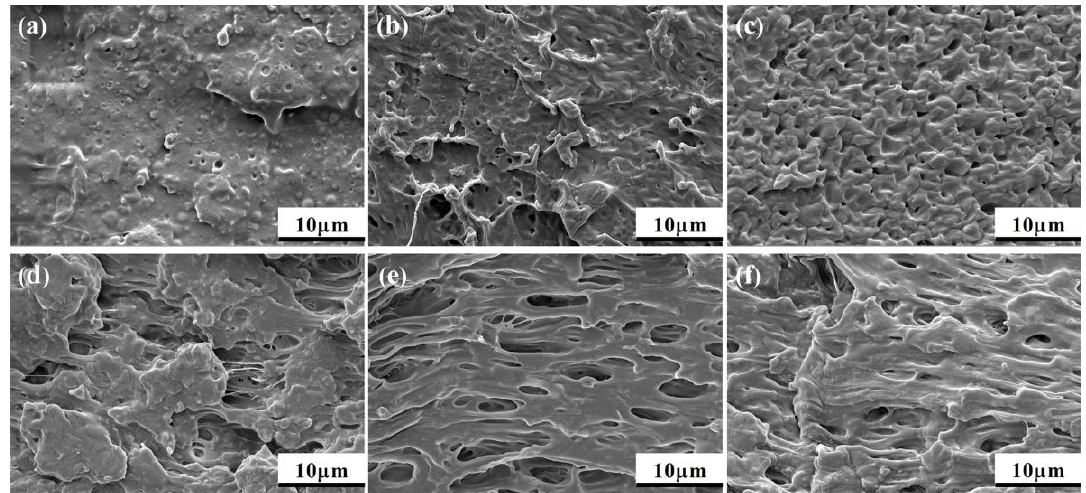
Figure 13. SEM images of the impact fracture surfaces: ( a ) PLA/PCL; ( b ) PLA/PCL/2; ( c ) PLA/PCL/4; ( d ) PLA/PCL/6; ( e ) PLA/PCL/8; and ( f ) PLA/PCL/10.